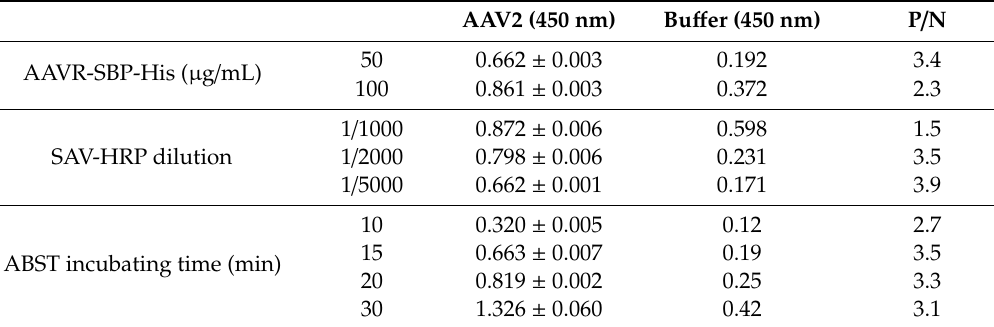
Table 1. Optimization of assay conditions for VIRELISA.